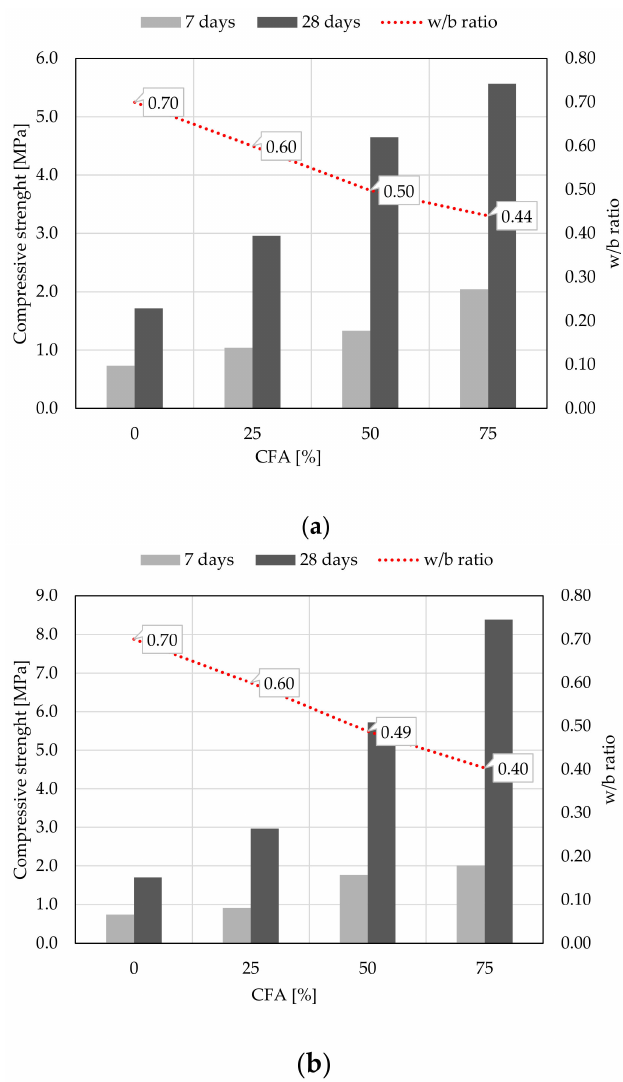
Figure 8. Compressive strength of mortars: ( a ) WBA1 and CFA binders, ( b ) WBA2 and CFA binders. With further hydration, an increase in compressive strength results is seen for all specimens. The strength values for 28 days are 2.5 and 3 times higher than the results of compressive strength after 7 days, Figure 8. The difference in chemical composition and physical parameters of the used WBA is visible when testing mixtures with CFA; higher reactivity is observed for samples with 50 and 25% WBA2, and 50 and 25% CFA. A high LOI and alkali content [22,74–77] could lead to a reduction in compressive strength, as in the WBA1 samples. Despite the fact that commercial HL was not used in this study, the mechanical properties of the tested mortars with WBA gave excellent results after 28